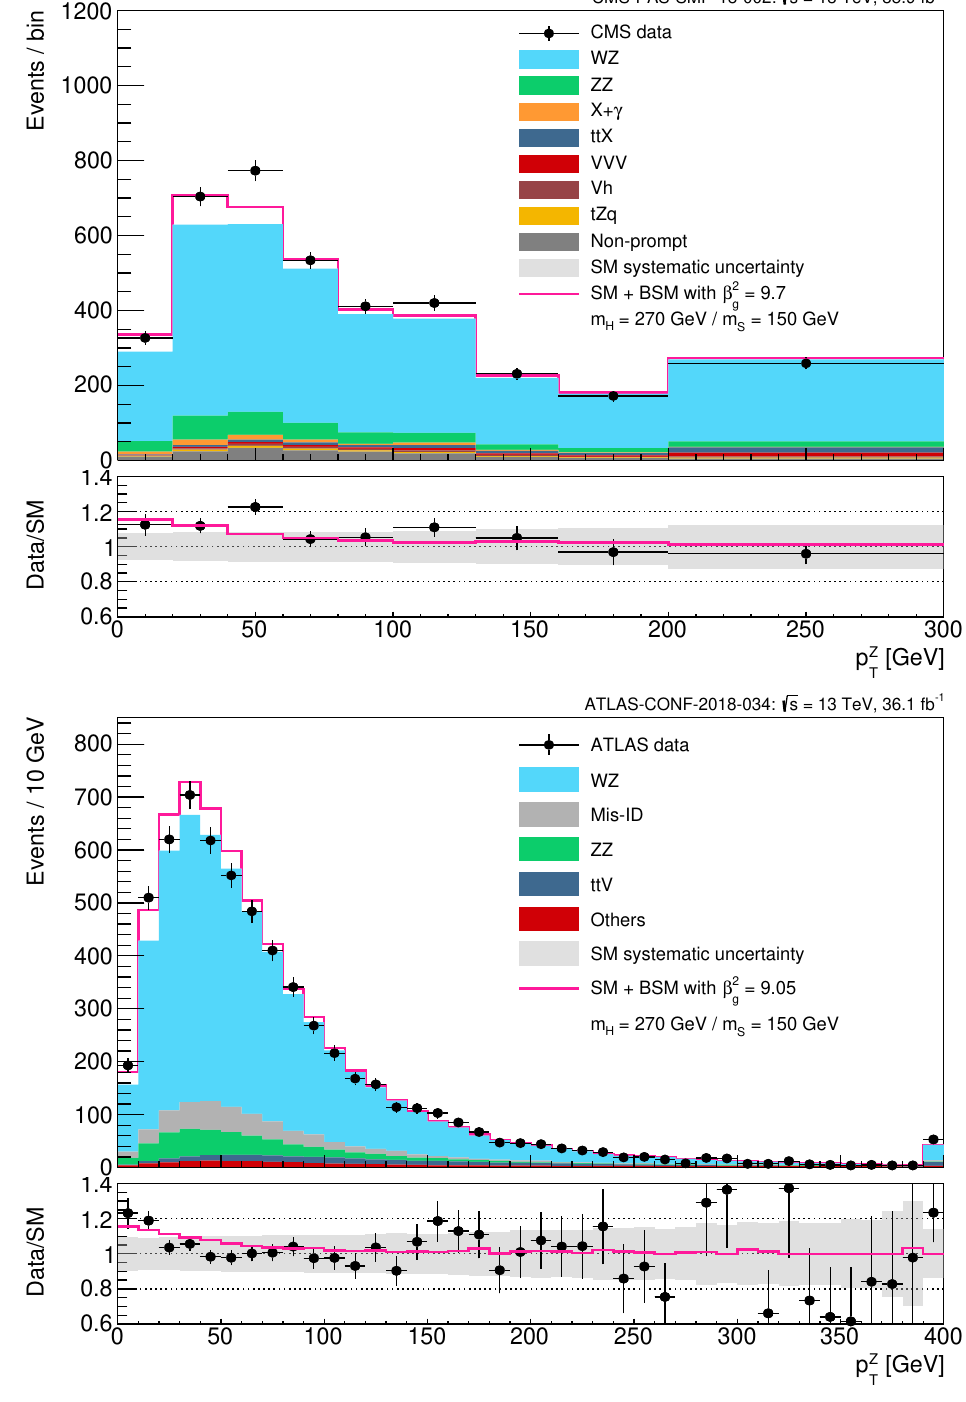
Figure 7 . The SM+BSM (cid:12)t result for the CMS (top) and ATLAS (bottom) measurements of SM WZ production. Only the BSM prediction has been scaled to its best-(cid:12)t value. The SM predictions and their associated uncertainties have been left at their nominal values.